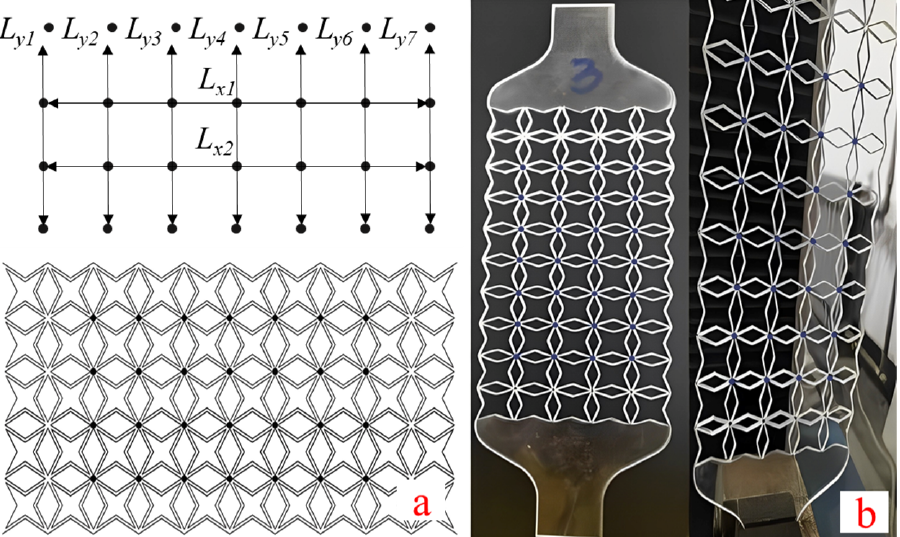
Figure 7. Poisson’s ratio measurement. ( a ) schematic diagram of marked points, ( b ) test sample.